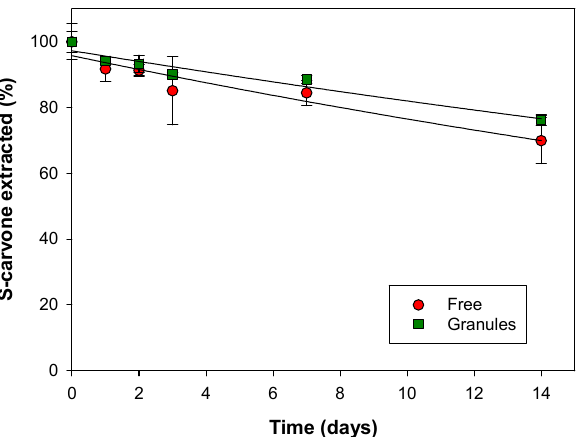
Figure 3. Dissipation curves for S-carvone applied to soil as free compound or supported on granules of Cloisite ® 10A. Symbols denote experimental data points and lines are the dissipation curves fitted by the first-order kinetics. Error bars designate the standard errors of triplicates. Table 1. Dissipation constants (k), half-lives (t 1/2 ), and R 2 for the dissipation of S-carvone in soil after its application as free compound or supported on granules of Cloisite ®